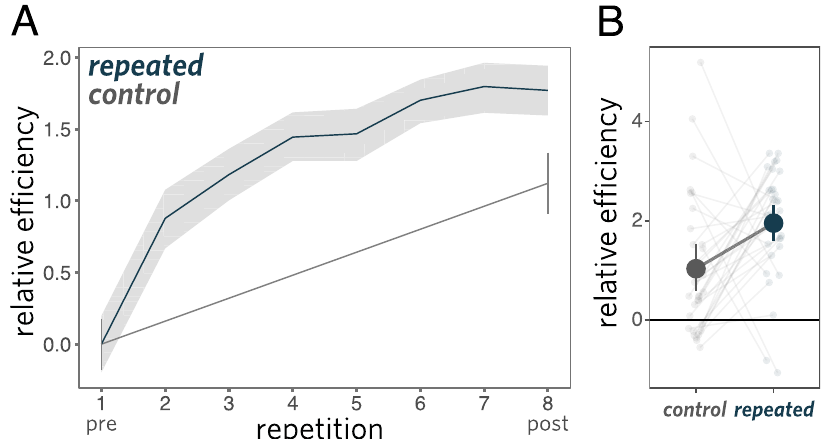
Fig. 3 | Performance on interaction communication experiment. Communica- tion ef fi ciency A across repetitions and B from the pre to post phase, where each line shows the effect for a given dyad. Ef fi ciency combines both speed and